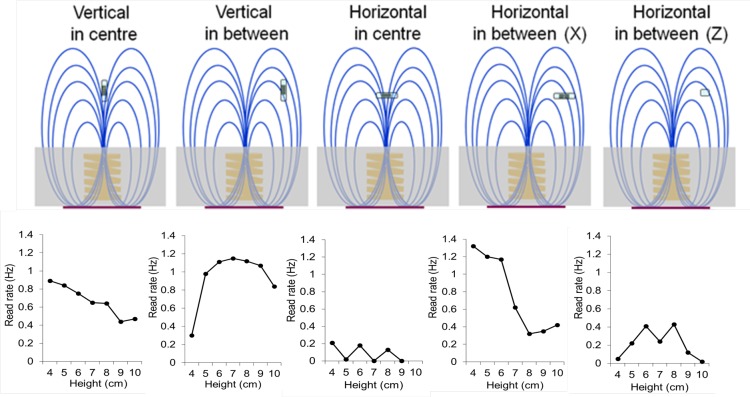
Impact of height and position on RFID transponder read rate.Mapping of signal strengths (as ‘read rates’) with an RFID transponder at different orientations, positions and heights with respect to a baseplate antenna. Upper panel: Diagram of magnetic fields of an active antenna and the orientation of the RFID transponder. ‘X’ and ‘Z’ indicate two planes of horizontal orientation, with the RFID transponder pointing towards the center of the antenna (X orientation) or at right angles to it (Z orientation) Lower panel: Read rate analysis for different orientations, positions and heights above the baseplate. These data underlie the schematic representation in Fig 2A–2D.